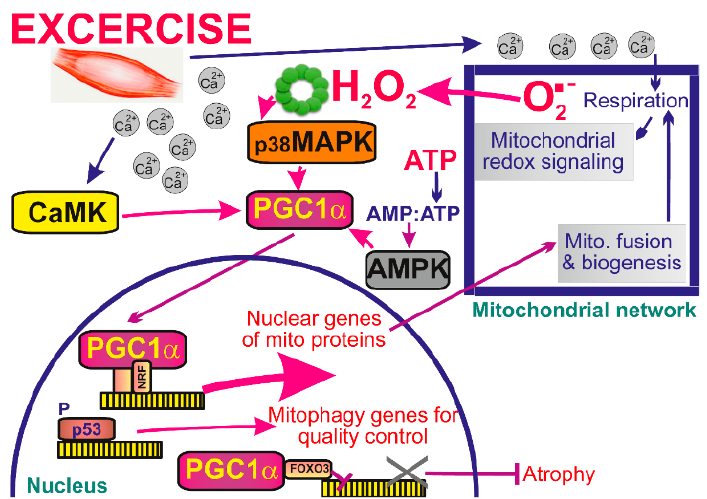
Figure 4. Mitochondrial signaling in skeletal muscle during exercise . During exercise cytoplasmic Ca 2+ concentration rises leading to activation of calcium-calmodulin-dependent kinase (CaMK) and increase in mitochondrial respiration, and subsequent increase in ATP and ROS production. While Ca 2+ acts via CaMK, the AMP/ATP ratio stimulates the AMP-activated protein kinase (AMPK) pathway and mitochondrial ROS target the p38 mitogen-activated protein kinase pathway (MAPK). All signals are then integrated in the increase of transcriptional activity of the master regulator of mitochondrial biogenesis, peroxisome proliferator-activated receptor-gamma coactivator-1 α (PGC1 α ).